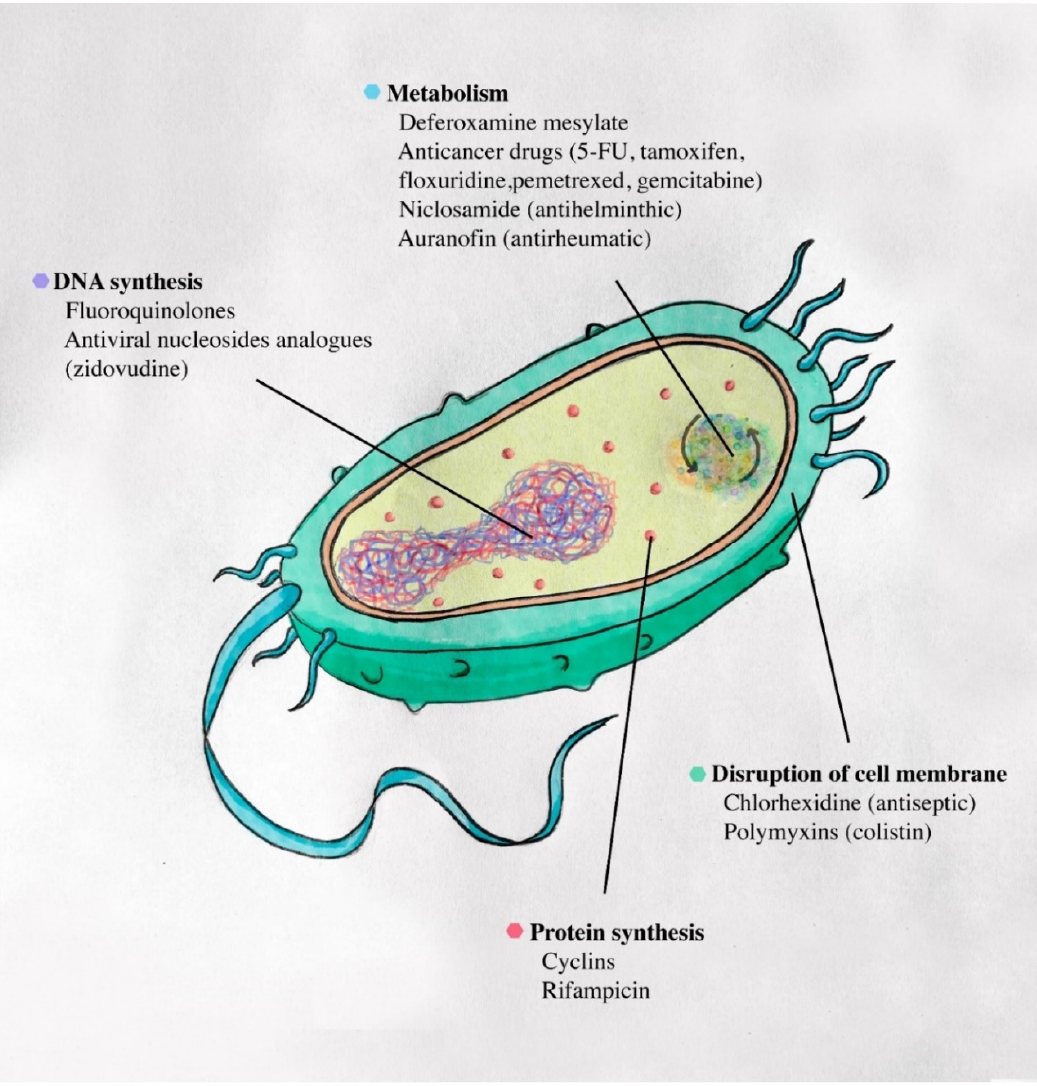
Figure 3. Mechanisms of action of in vitro effective drugs on Gram negative bacteria tested at 10 µM.